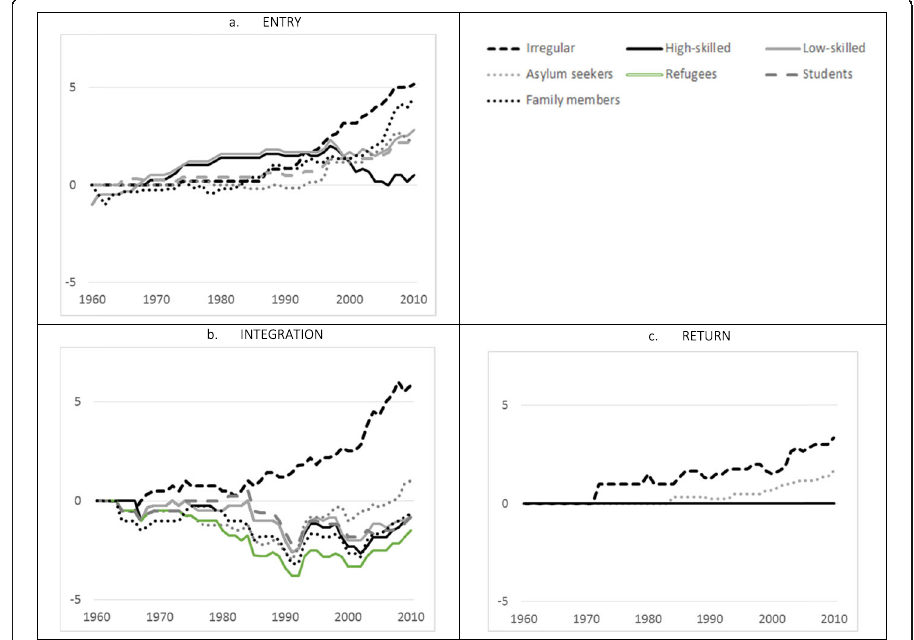
Fig. 2 Migration policy changes regarding entry, integration, and return of non-European migrants in Belgium, UK, France, Italy, Spain, and the Netherlands, 1960 – 2010 – average index. Note: Positive values on vertical axis = more restrictive. Negative values on vertical axis = less restrictive. Source: DEMIG POLICY database recoded by the